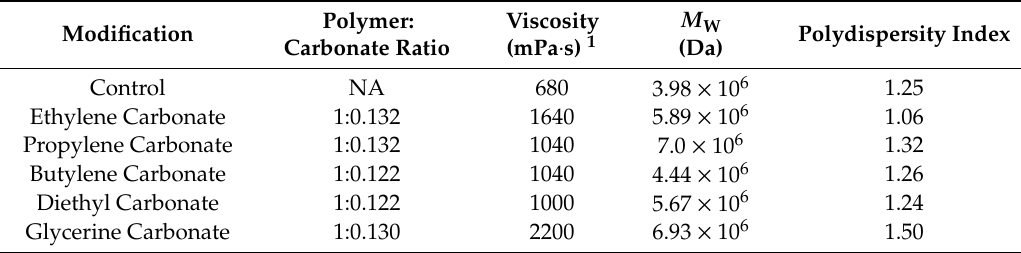
Table 2. The viscosity, M W and polydispersity index of various carbonate-modified Xanthan gum solutions (0.5 wt%) (data from